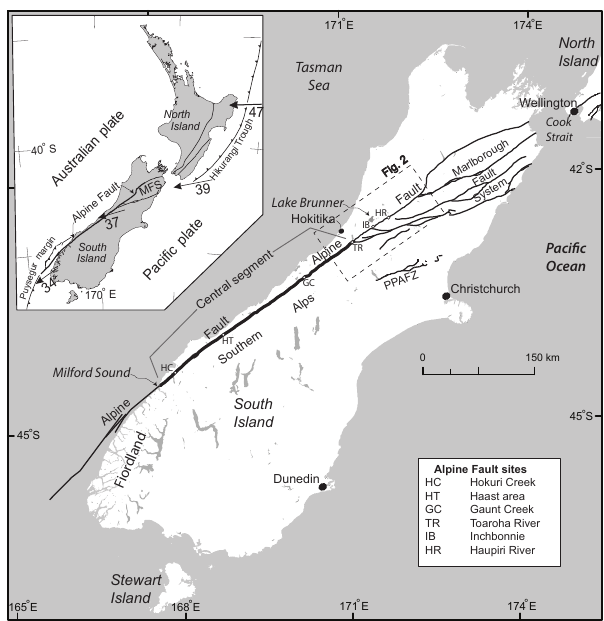
Fig. 1. Tectonic setting of South Island highlighting the Alpine Fault, Marlborough Fault System (MFS) and Porters Pass- Amberley Fault Zone (PPAFZ). The Central segment of the Alpine Fault is marked in bold. Alpine Fault paleoseismic sites are shown in the legend. Lake Poerua is located between Lake Brunner and Inchbonnie. Inset: Relative motion between the Pacific and Aus- tralian plates is shown in mmyr − 1 from De Mets et al.